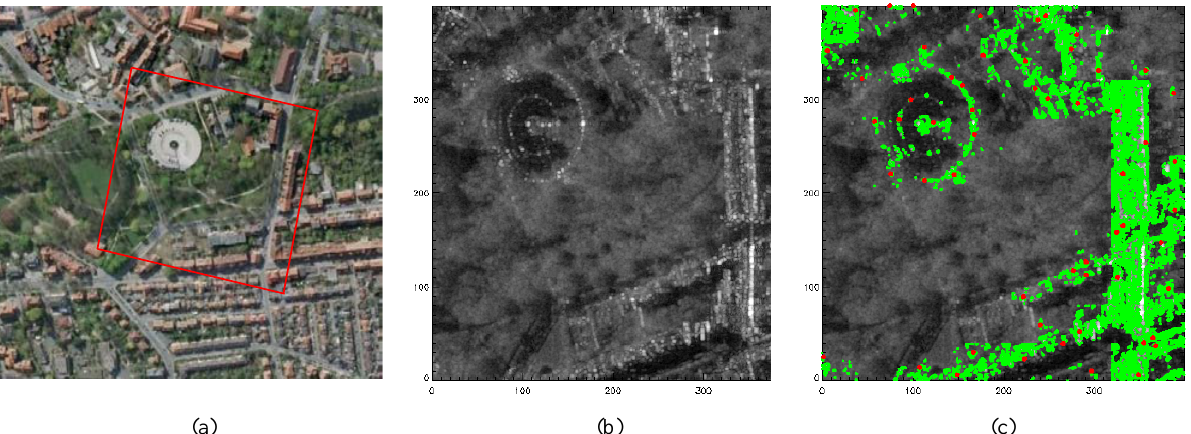
Figure 3: Identification of homogenous patches for a part of Lueneburg which has deformed highly in the considered time period. (a) is a Google Earth image of a small part of Lueneburg in Germany, the region of interest is enclosed in red. (b) is the mean amplitude image of the region of interest. (c) shows the homogenous pixels in green and the reference pixels in red.